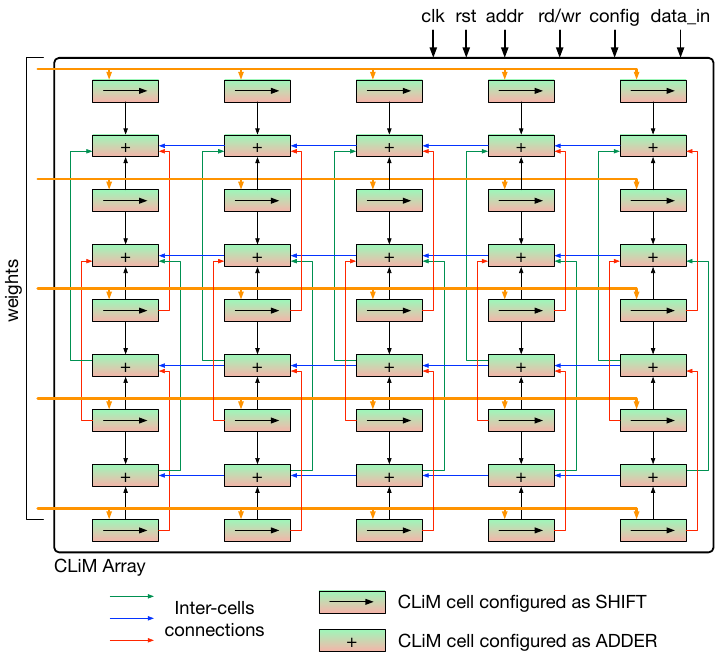
Figure 12. Interconnection fabric inside the CLiM array.